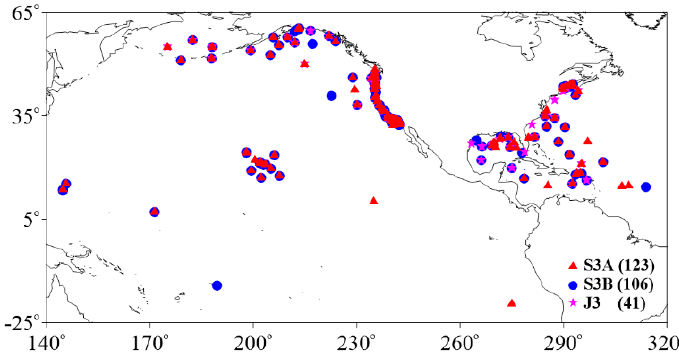
Figure 2. Spatial distributions of the National Data Buoy Center (NDBC) buoys matched to Sentinel-3A/3B and Jason-3 for significant wave height (SWH) validation.